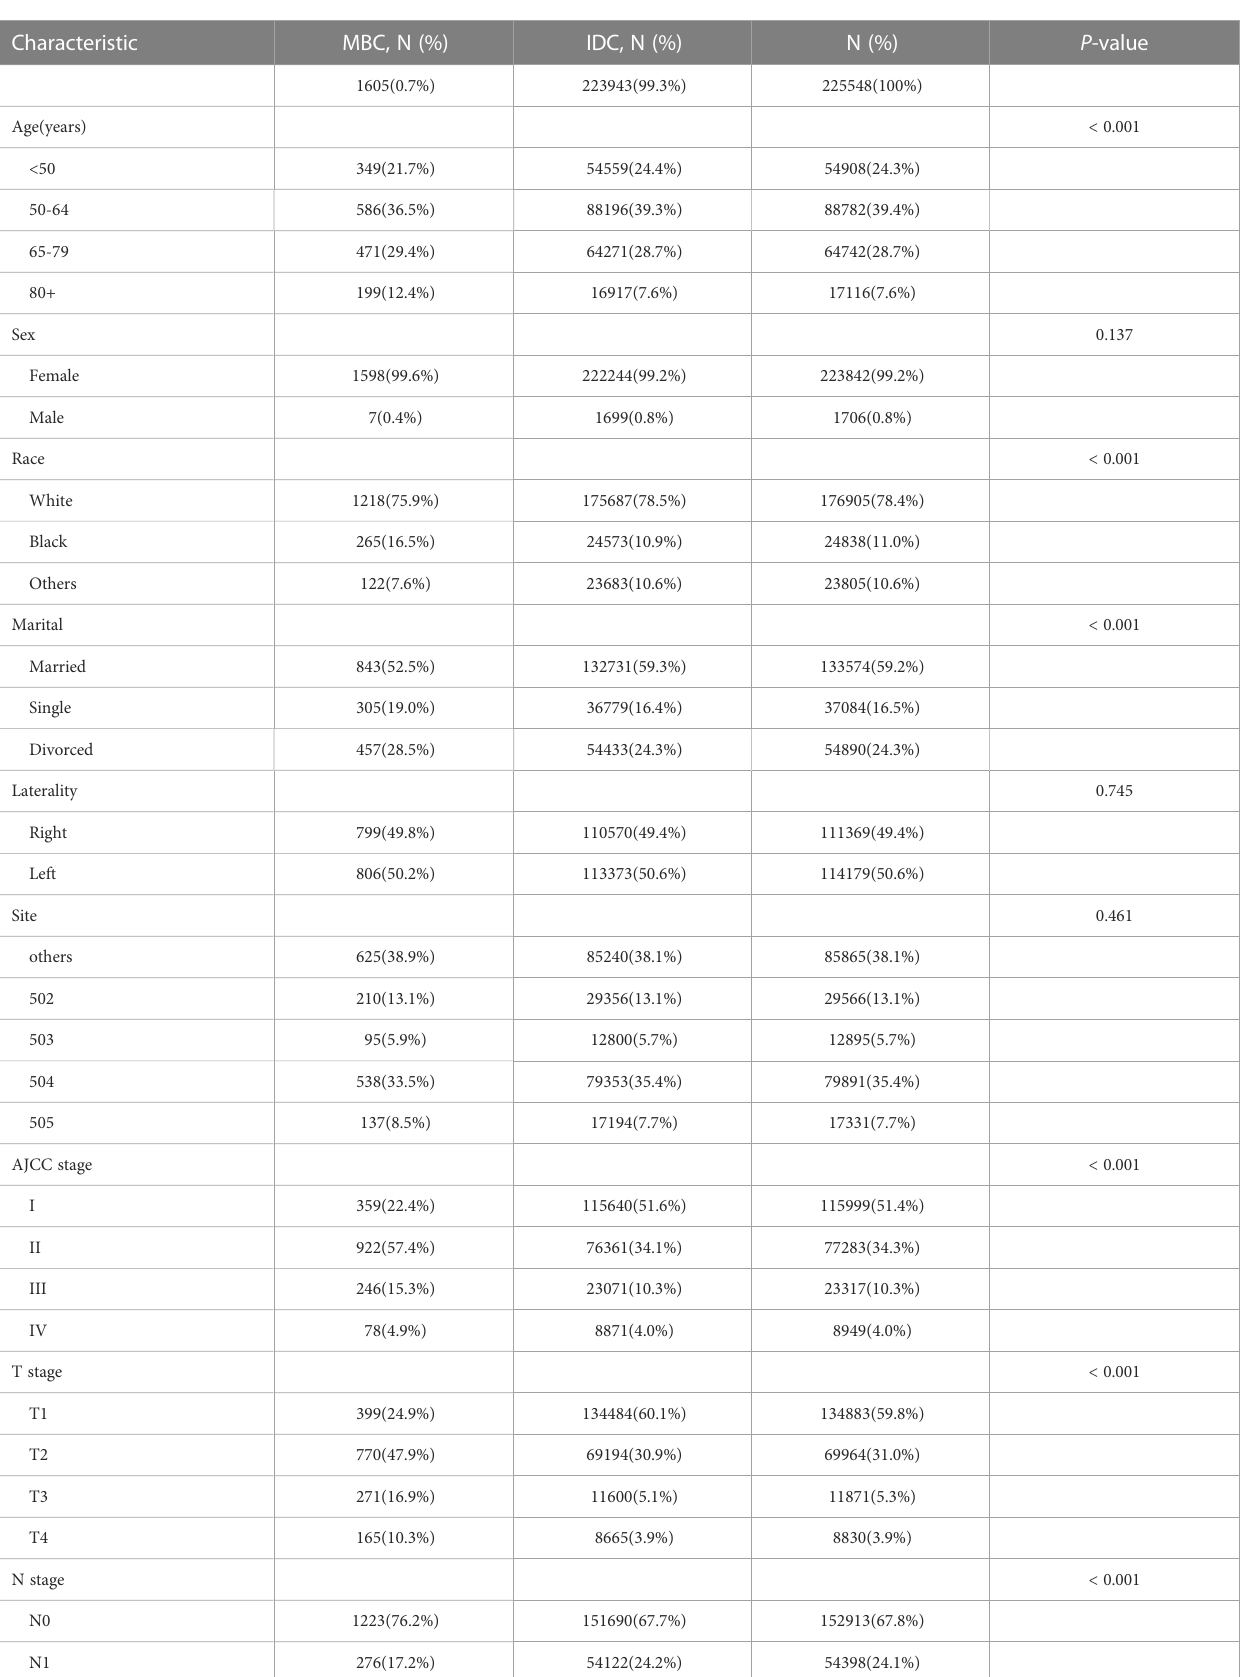
TABLE 1 The characteristics of 225,548 breast cancer patients.